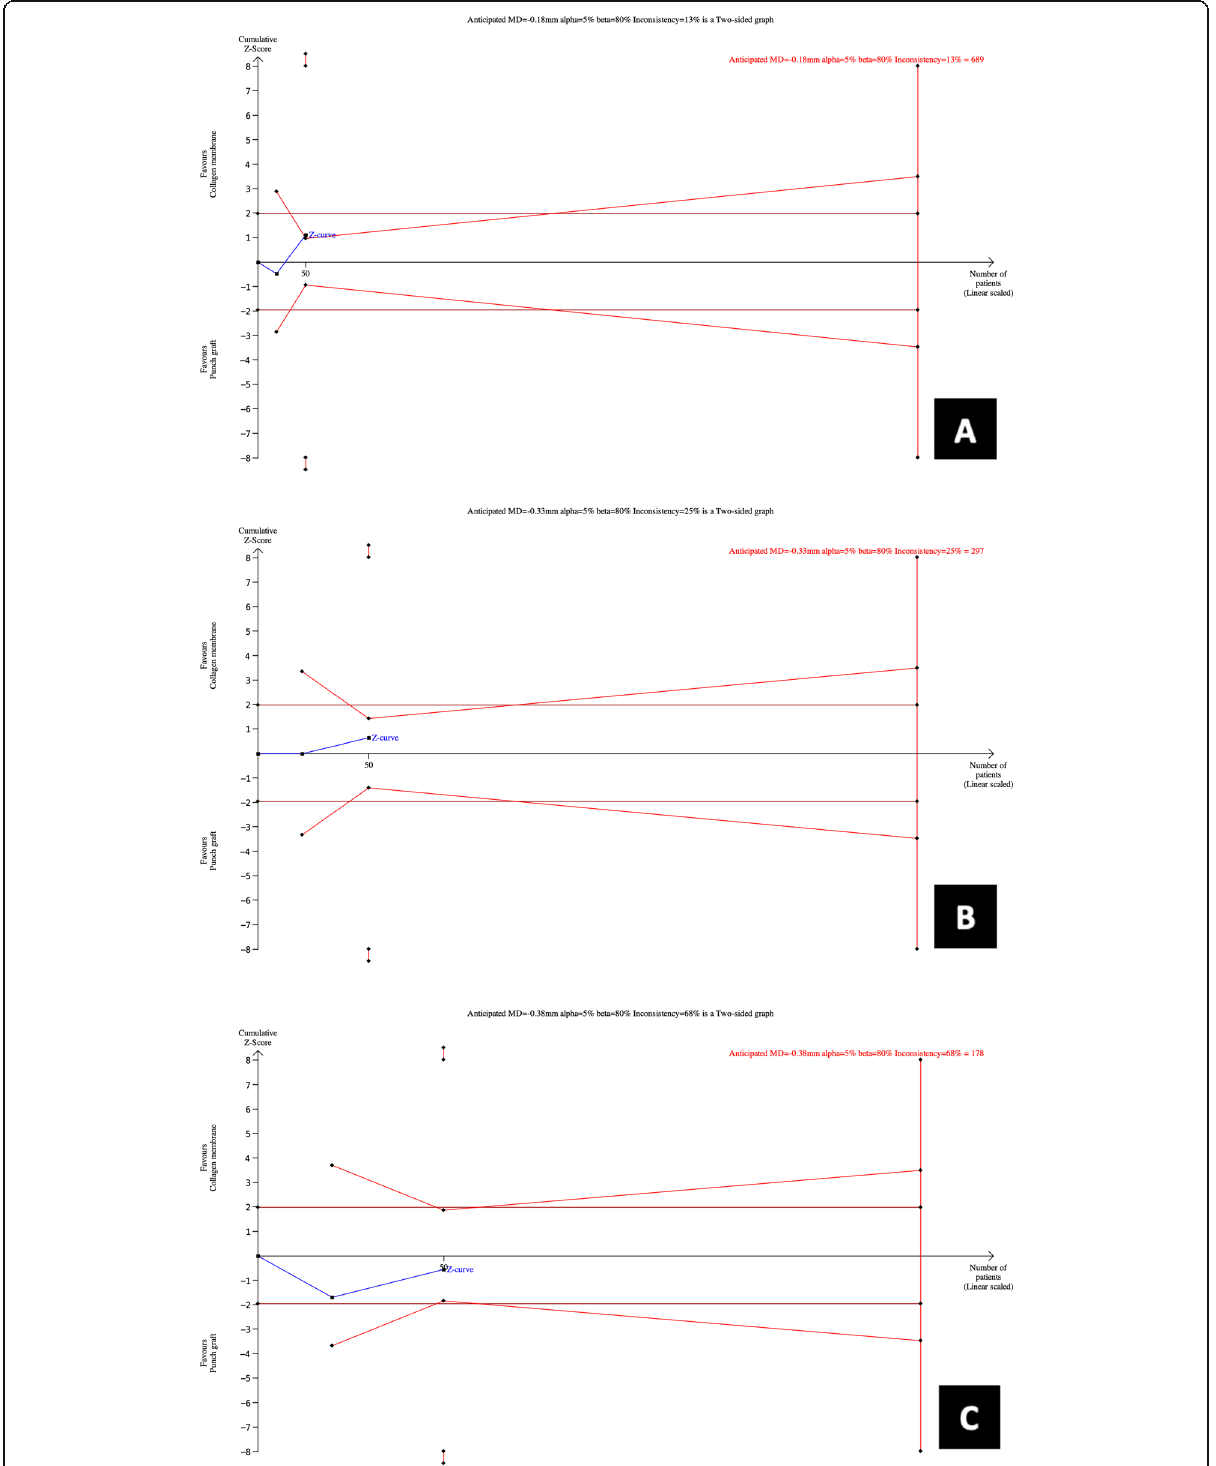
Fig. 4 Trial sequential analysis for required information size estimations. a RW − 1 mm. b RW – 3. c RW − 5